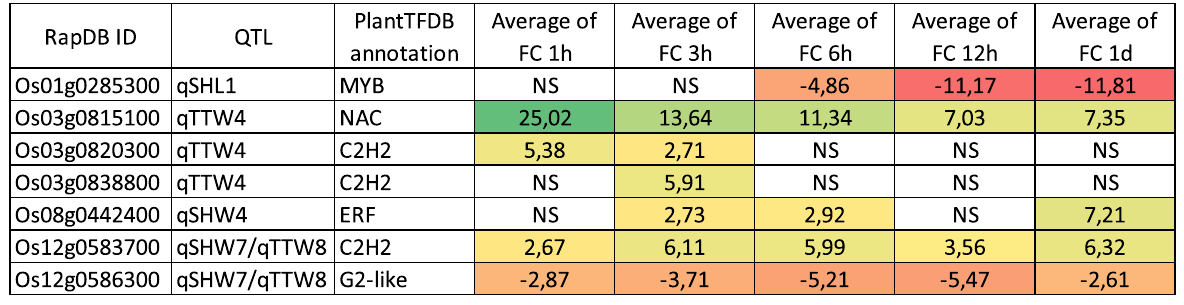
NS Not significant, FC Fold